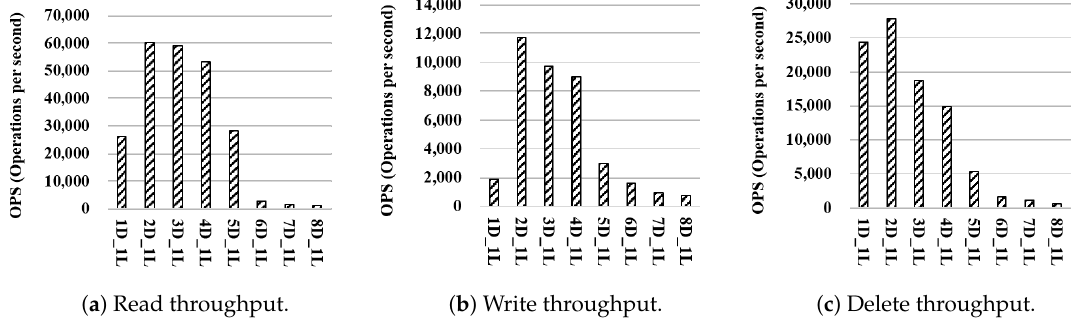
Figure 5. Performance of WR-Store as WR D is varied. ( a ); Read throughput ( b ); Write